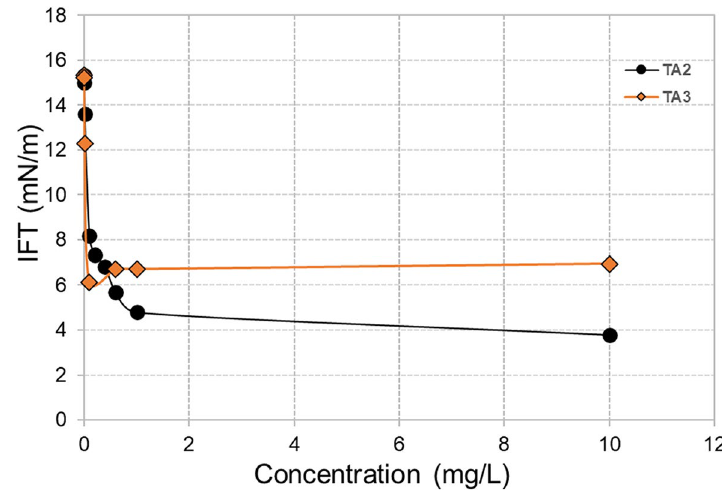
Fig. 6 Effect of surfactant concentrations on IFT reduction used for CMC